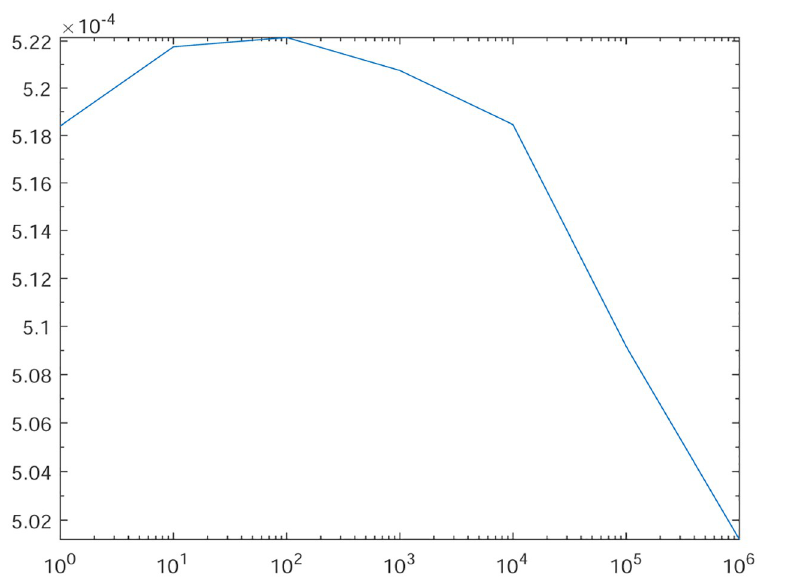
Fig 3. The behavior of the error with respect to the parameter θ for the Experiment